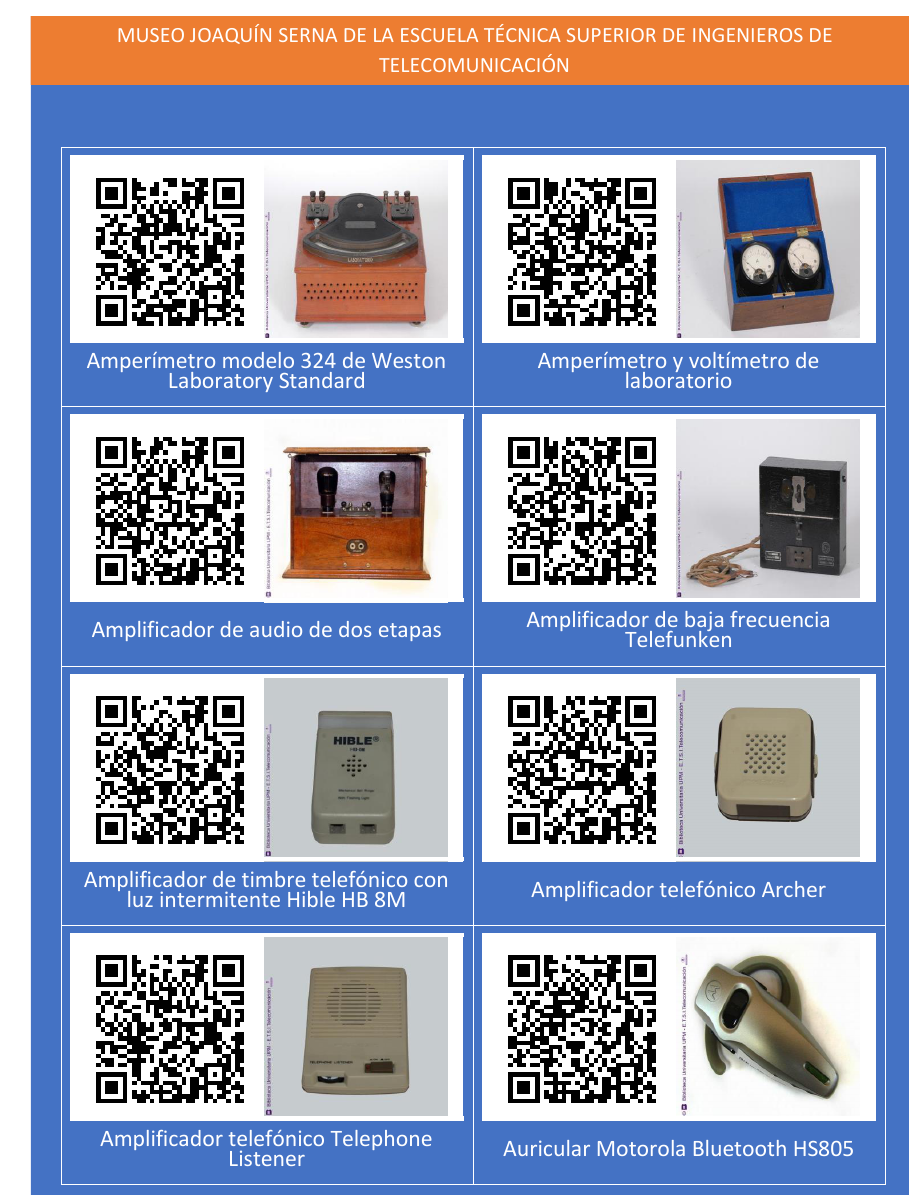
Figure 4. Cardboard example template used to display QR